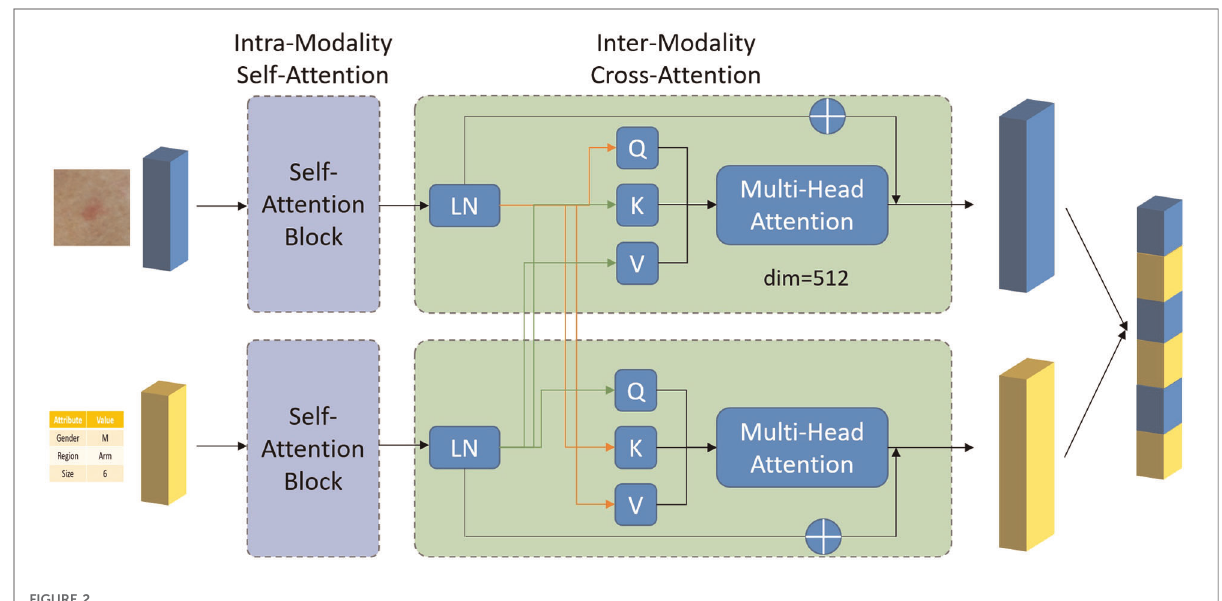
FIGURE 2 Network architecture of the proposed multimodal fusion